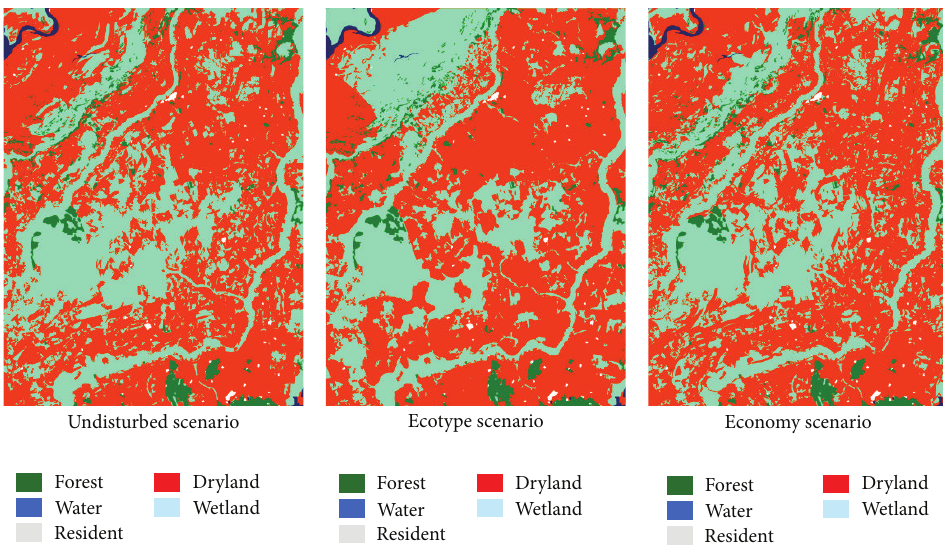
Figure 5: The results of scenarios planning based on multi-agent adjustment.